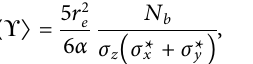
Frontiers in Physics |